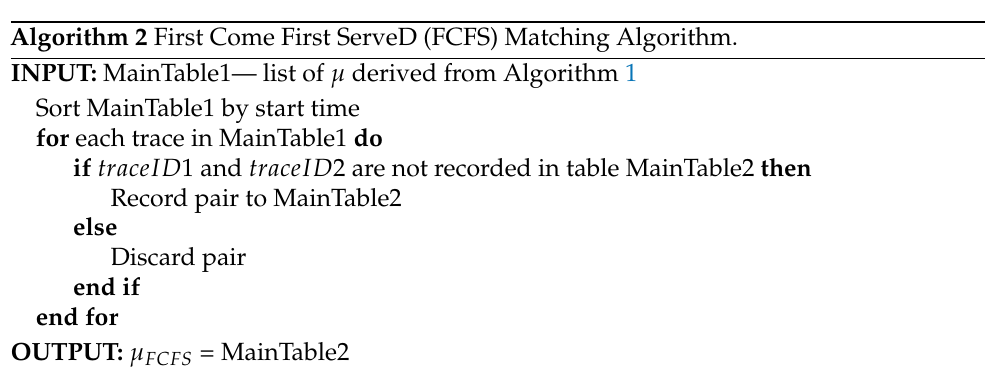
Algorithm 2 First Come First ServeD (FCFS) Matching